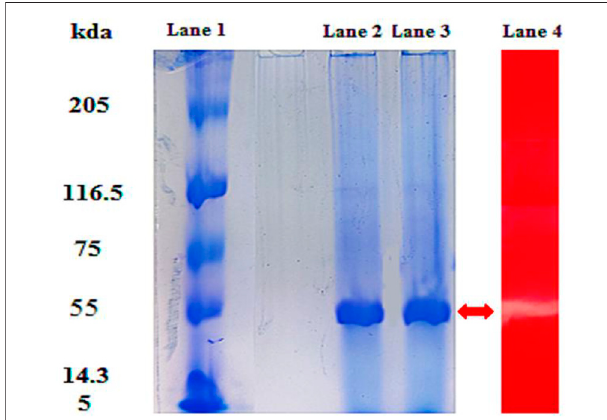
FIGURE 2 | SDS-PAGE and zymogram analysis of cellulase. Lane 1 represents standard molecular weight marker proteins in kDa. Lane 2 and Lane 3 show a single band at approximately 55 kDa, and Lane 4 (L4) shows the zymogram of partially puri fi ed